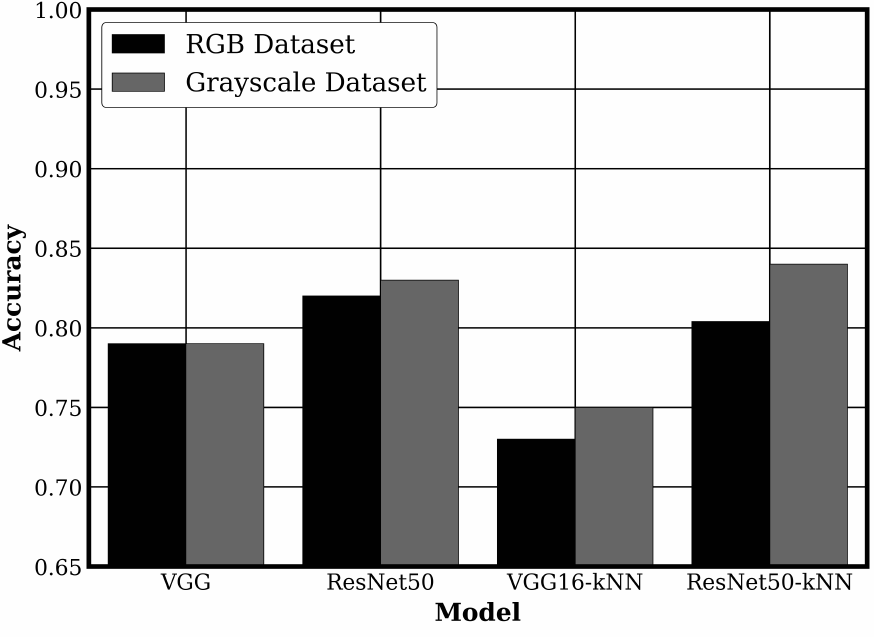
Figure 10. Comparison of accuracy from each model in RGB and greyscale